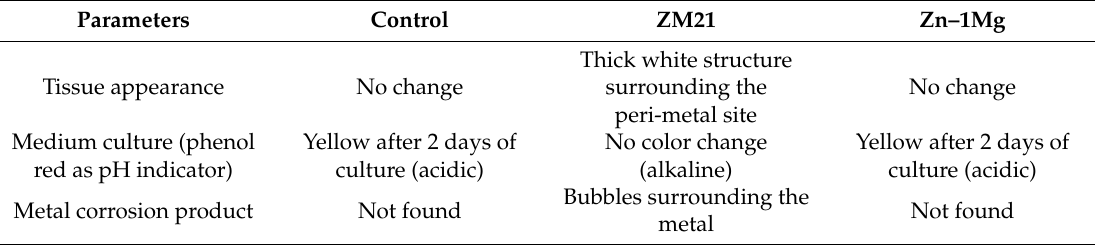
Table 2. Macroscopic changes on the UW model observed after 1